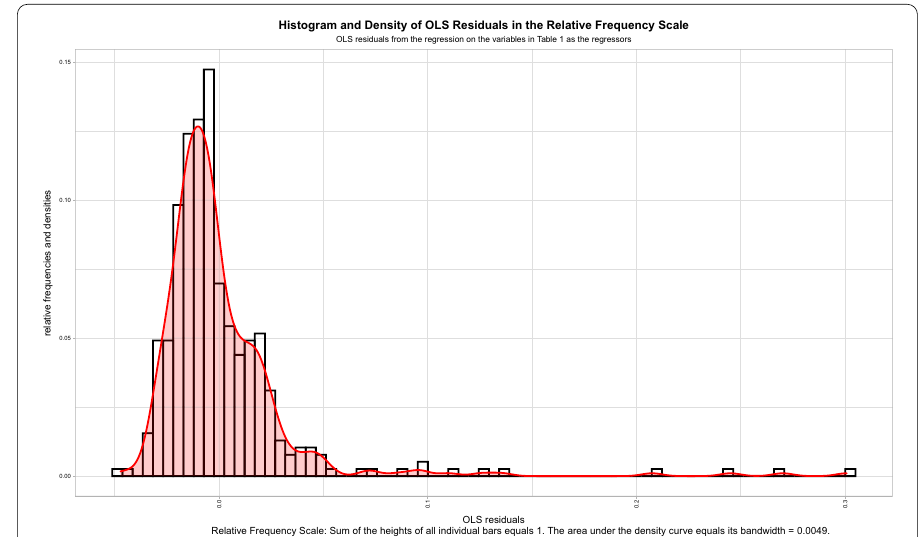
Fig. 8 Histogram and density of the OLS residuals from the linear regression formulated by using the variables in Table